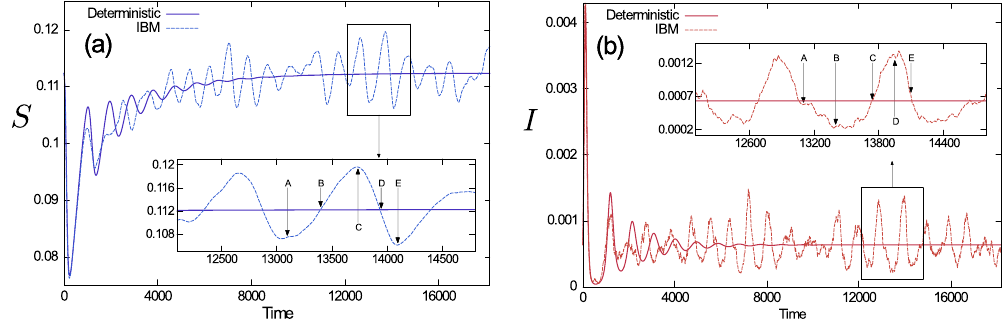
Figure 2. Population dynamics. Time series of the population density of total susceptible (panel (a)) and total infected individuals (panel (b)). Noise-sustained oscillations are clearly seen. The insets show a zoom in on the cycles. Labels A B E , , , … are for later purposes (see